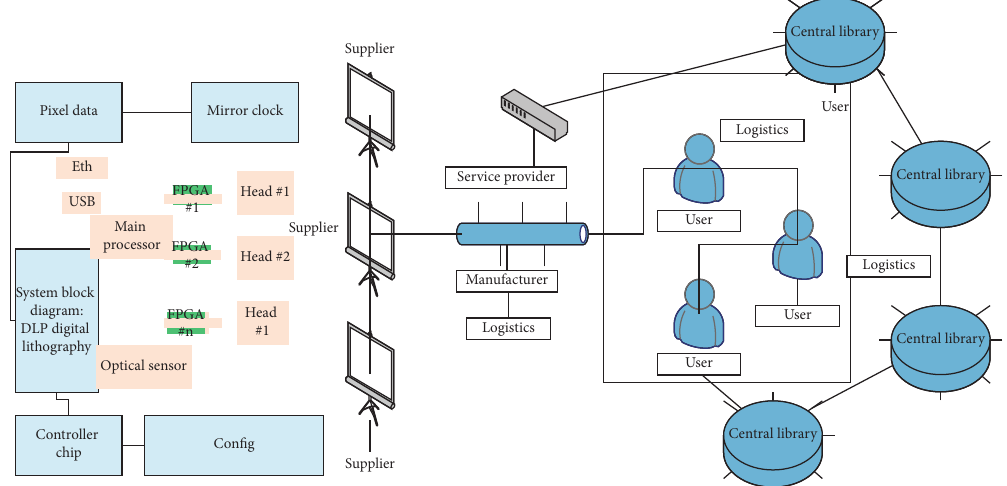
Figure 1: Traditional value chain